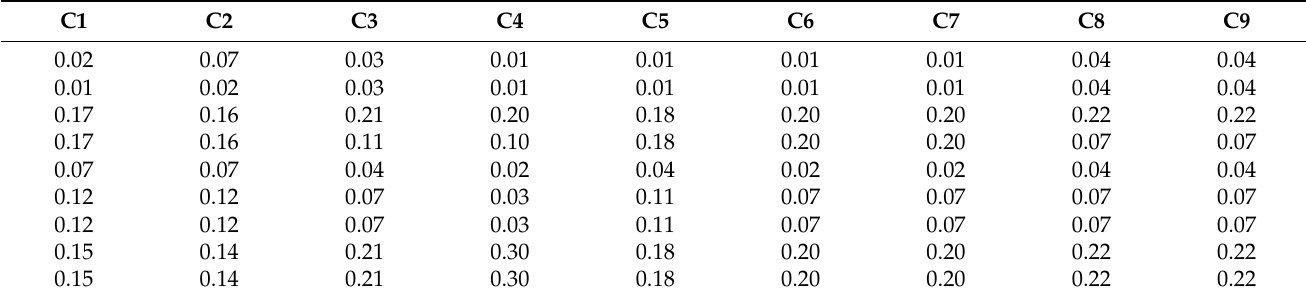
Table A2. AHP normalized matrix.